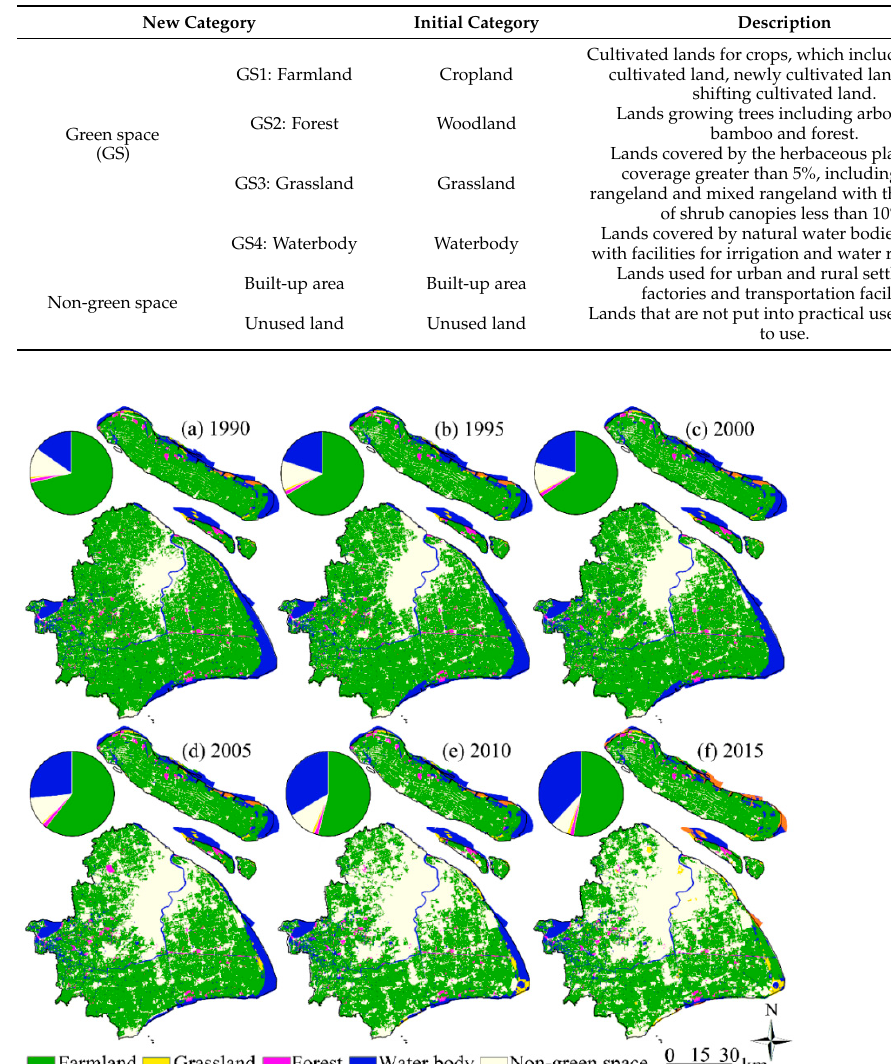
Figure 2. Remote sensing-based land use patterns of Shanghai from 1990 to 2015. ( a ) The land use patterns in 1990; ( b ) The land use patterns in 1995; ( c ) The land use patterns in 2000; ( d ) The land use patterns in 2005; ( e ) The land use patterns in 2010; ( f ) The land use patterns in 2015 .